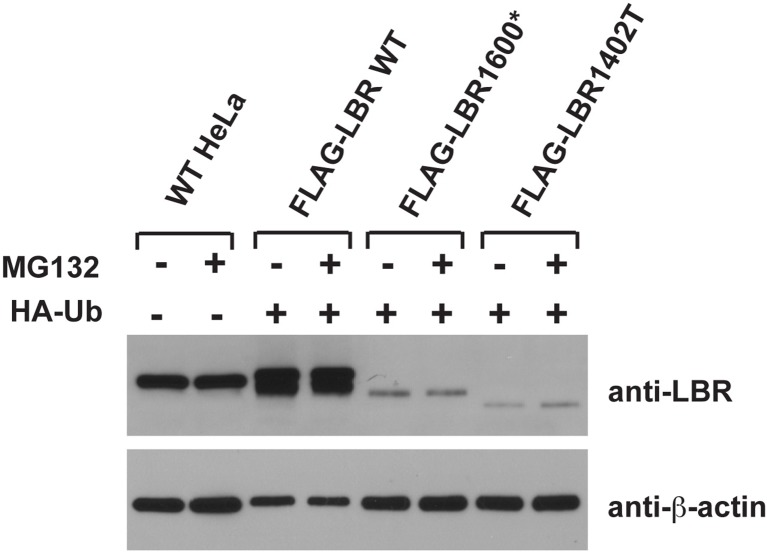
DOI:
http://dx.doi.org/10.7554/eLife.16011.020